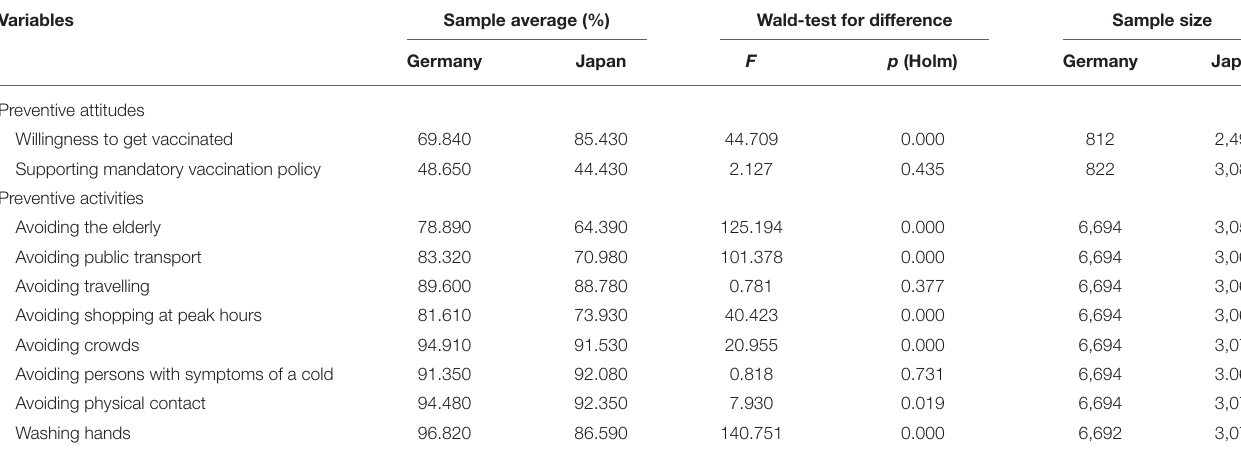
TABLE 1 | Preventive attitudes and behaviors by